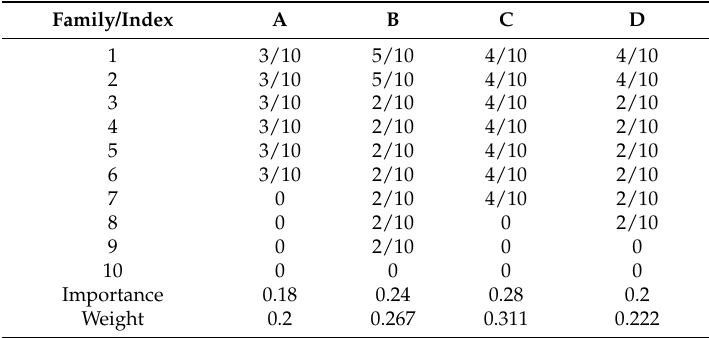
Table 11. The attribute significance of the first-level index.